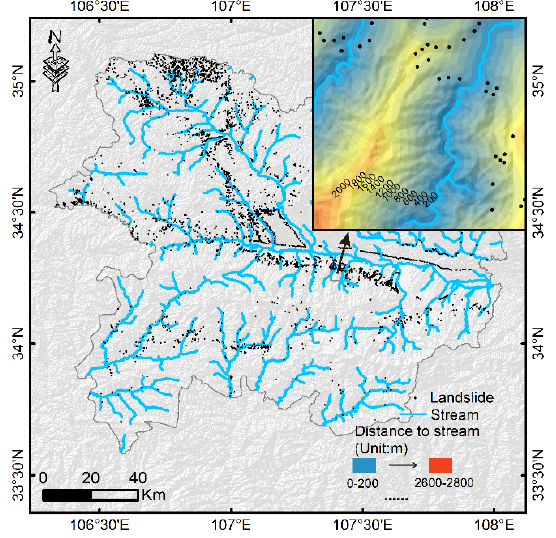
Figure 7. Elevation in the study area and distribution of districts and counties. FC—Feng County,